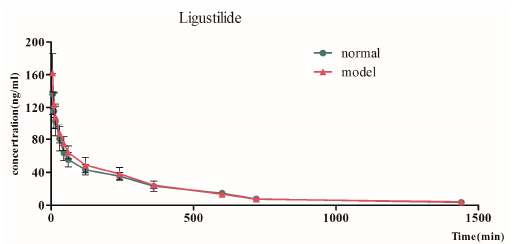
Figure 2. Mean plasma concentration-time curves of seven components after oral administration of Gui-Hong extracts to normal and blood stasis rats.